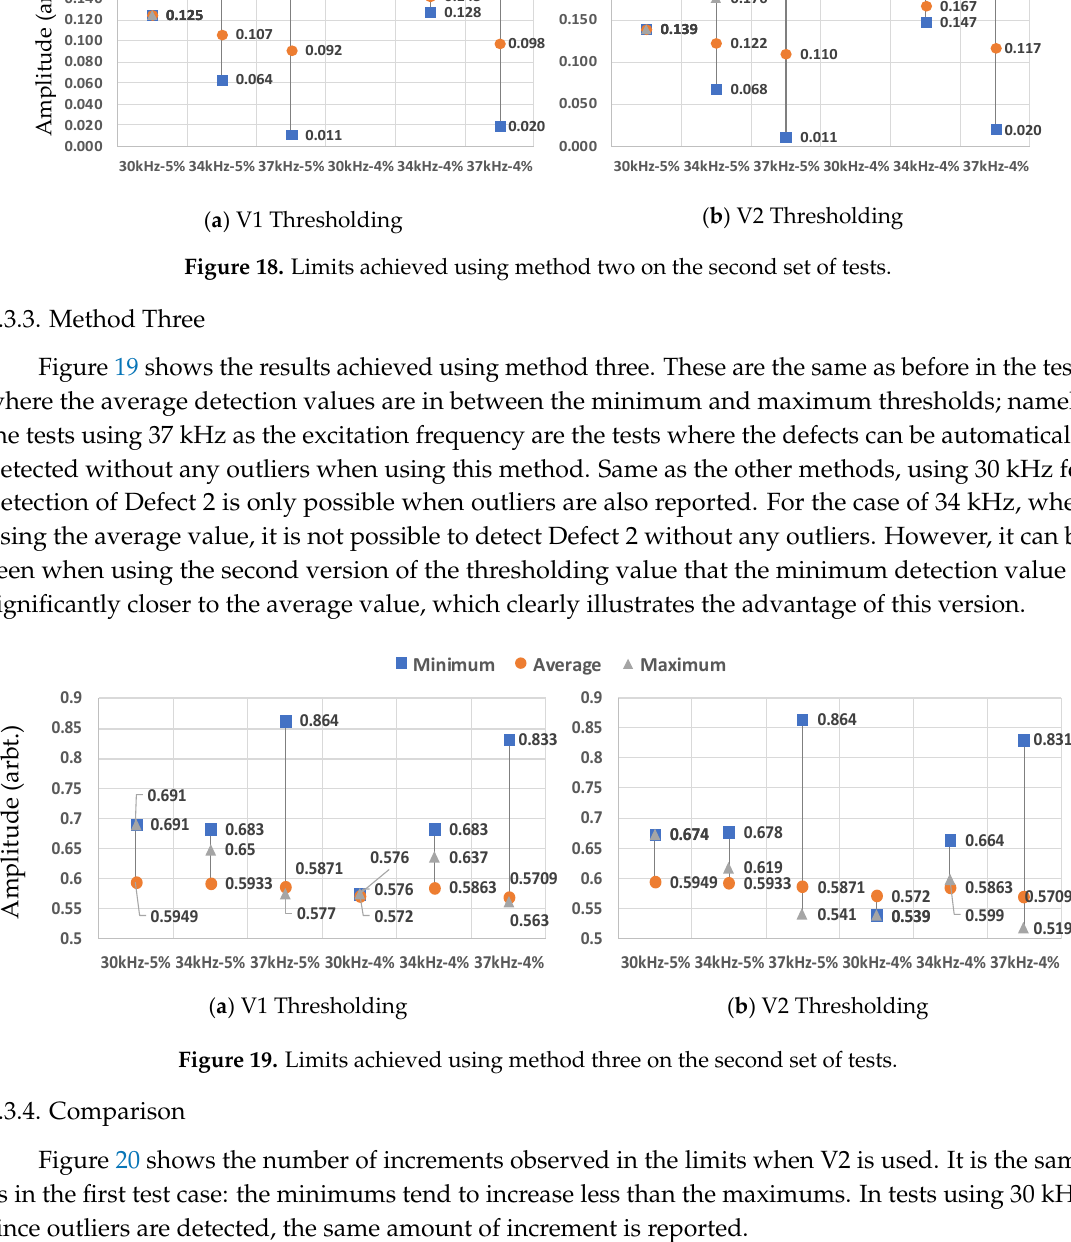
Figure 20. The increments achieved using the second version of thresholding in the second set of tests. The generated safe zone margins for the second set of tests are demonstrated in Figure 21. As expected, V2 always provides a greater safe zone margin. This is especially important in the case of method three, since generally, the minimums that are required for detection are well above the average value, while the maximums are close. The benefit of using V2 is clearly illustrated in Figure 19, where upon testing with the 34-kHz frequency, the maximum detection value of V2 in both tests is much closer to the calculated average value.